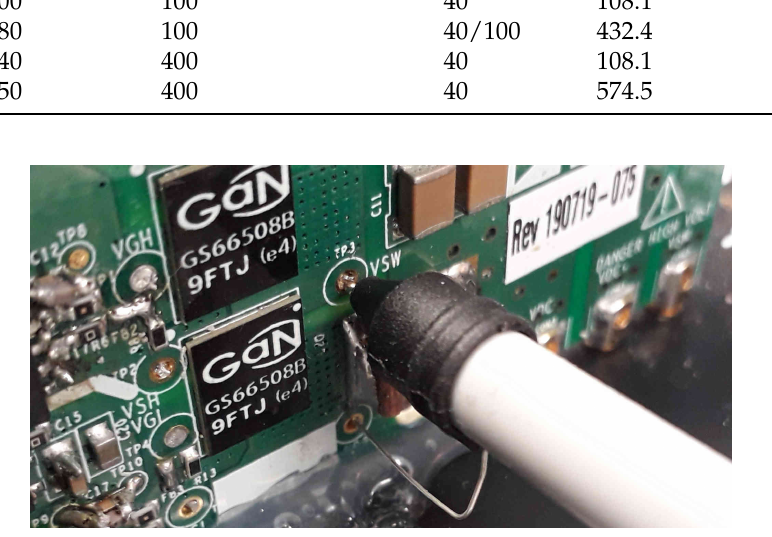
Figure 17. Drain-source voltage measurement technique.